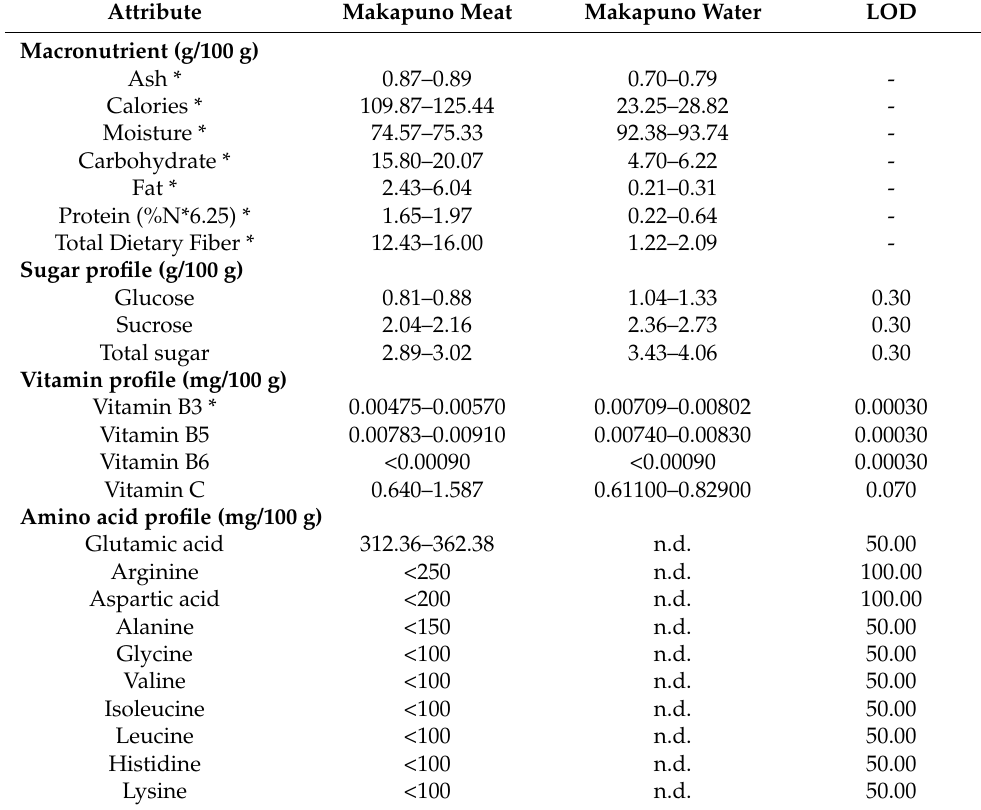
Table 1. Macronutrients, vitamins, and amino acid profiles of Makapuno meat and water.